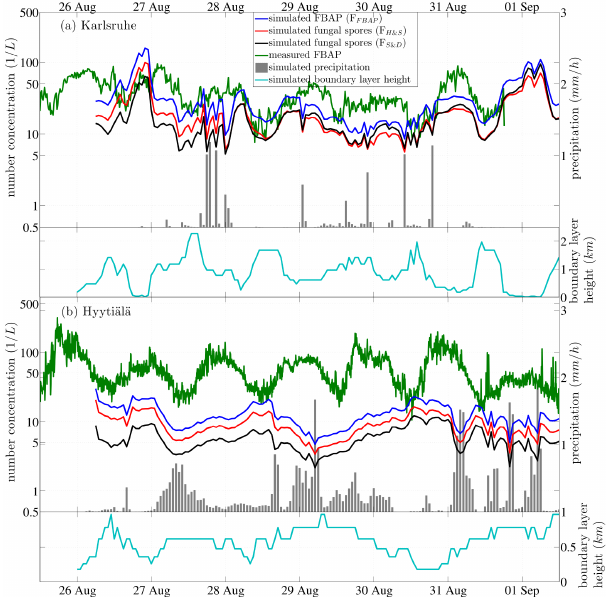
Figure 6. Time series of measured FBAP and simulated fungal spore number/FBAP concentrations in 1L − 1 together with simu- lated precipitation in mmh − 1 (right axis) and simulated bound- ary layer height in kilometers (right axis) during the case study from 26 August 2010 to 1 September 2010 at (a) Manchester, UK, and (b) Killarney, Ireland. Simulations were performed with three different emission parameterizations: F H&S from Heald and Spracklen (2009); F S&D from Sesartic and Dallafior (2011); F FBAP from this study. Table 3. Correlation coefficient ( R ) and confidence intervals for correlations between observed FBAP concentrations and the inverse boundary layer height at different locations and three different time periods.